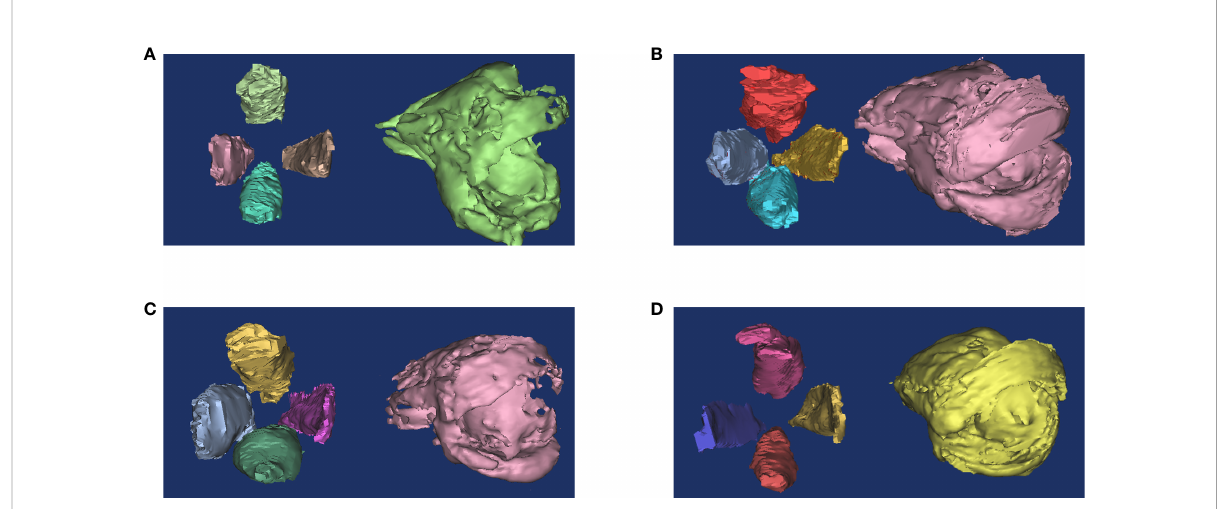
FIGURE 2 Reconstruction of orbital fat and EOMs. The ratio of orbital fat and EOMs usually change in GO patients. (A) Healthy people. (B) Both fat and muscle volume increased. (C) Muscle volume increased only. (D) Fat volume increased only. This fi gure is original and the classi fi cation is based on